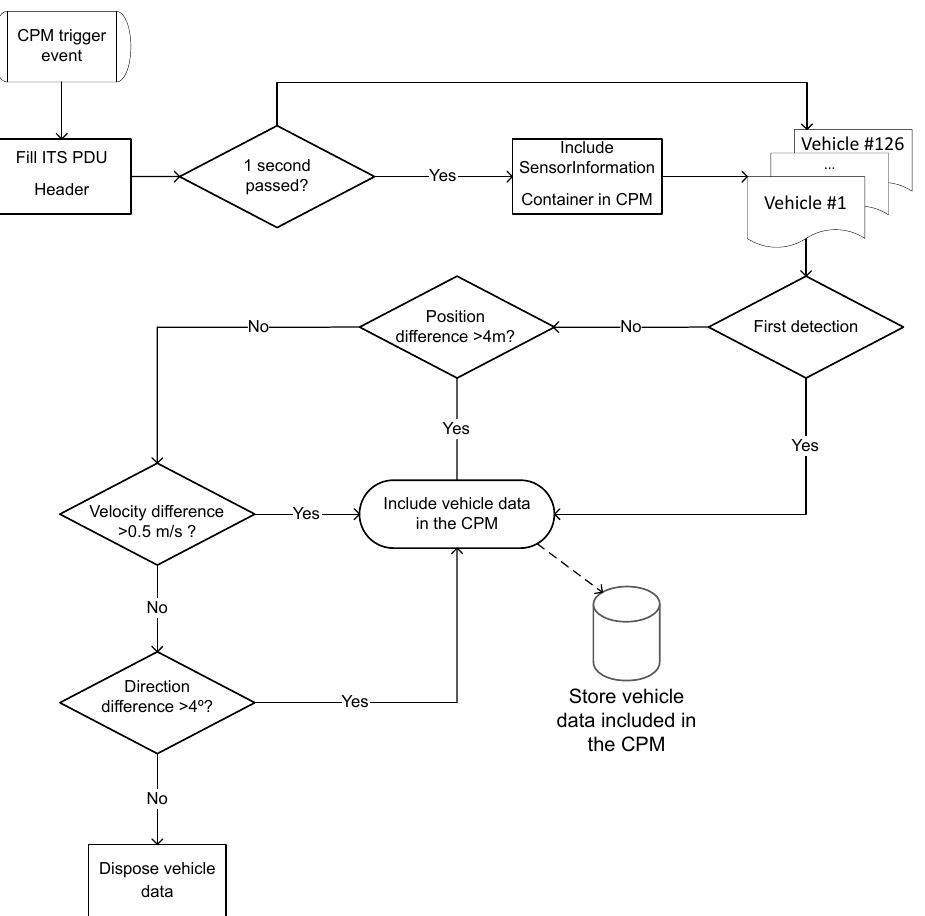
Figure 10. CPM generation rules